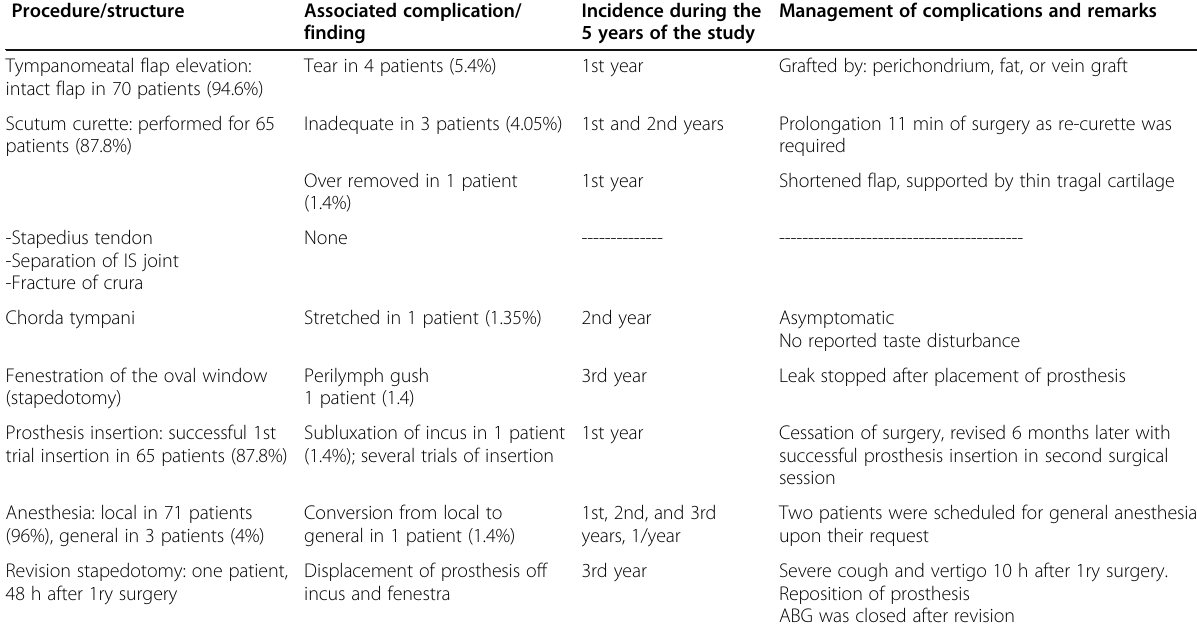
Table 1 Surgical steps of endoscopic stapedotomy for 74 patients, complications, and associated interventions during the 5 years (2016 – 2020) of the study. IS incudostapedial joint, 1ry primary, ABG air bone gap Procedure/structure